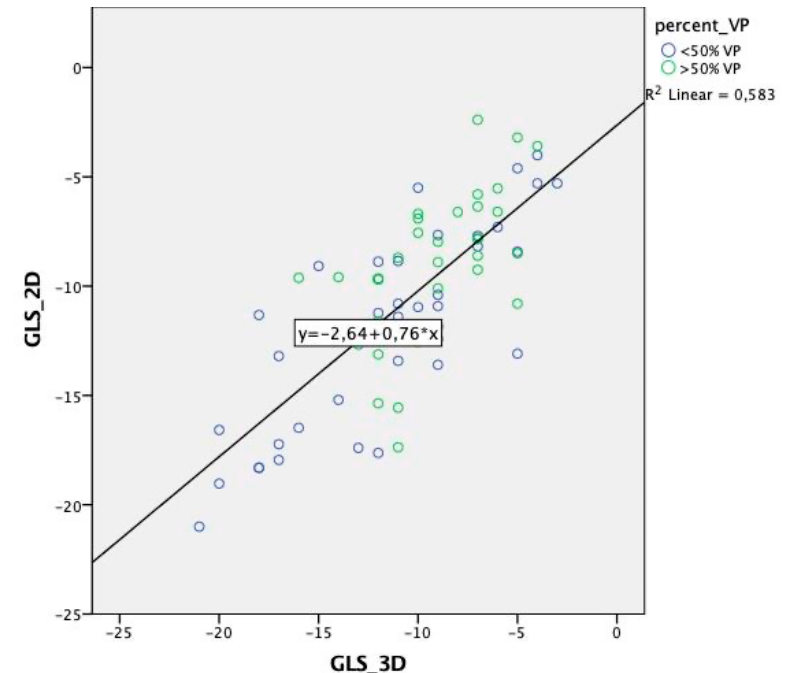
Figure 5. Scatter plot of 2D vs. 3D global longitudinal strain. Sorted by the amount of right ventricular pacing (VP) with displayed regression equation.